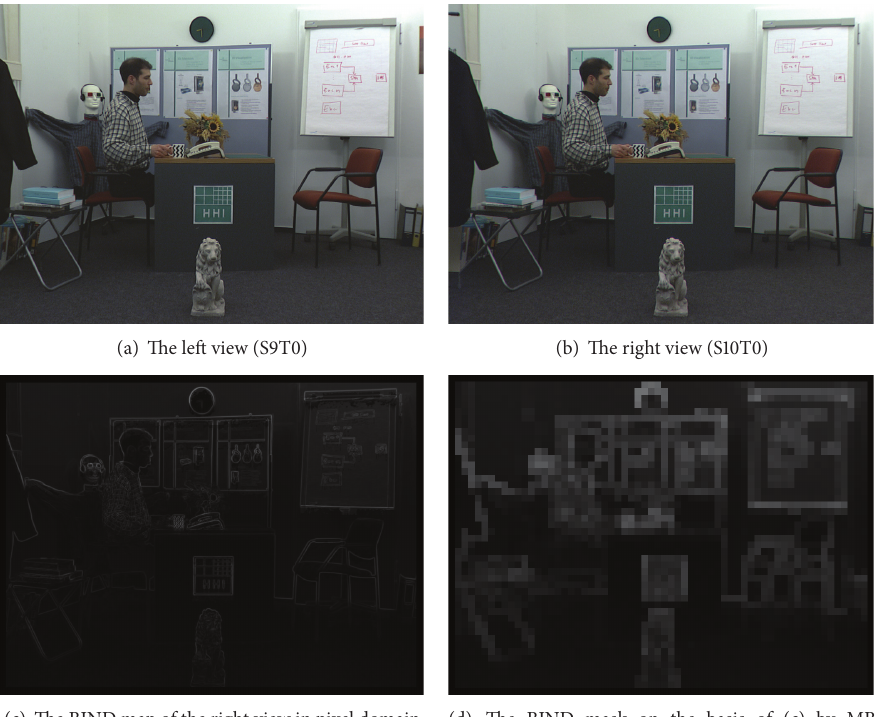
Figure 3: The BJND of the BookArrival sequence.